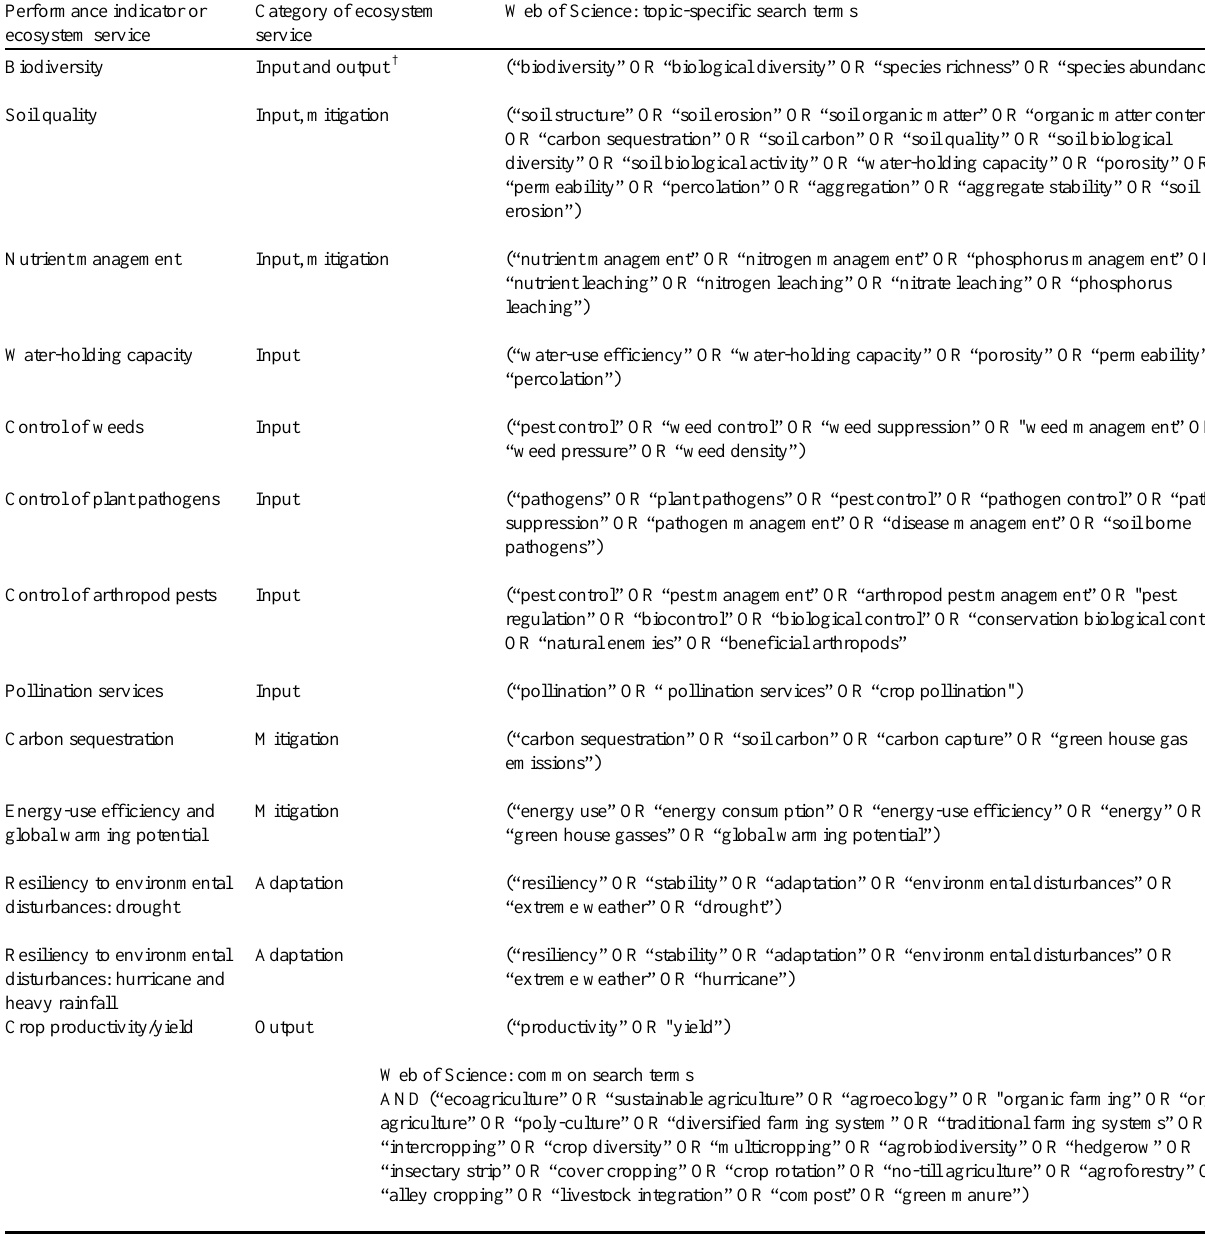
Table 2 . Search terms utilized for each ecosystem service. Services are categorized as to whether they provide an input to farming, an output from farming, mitigation of an environmental externality, or adaptation to global